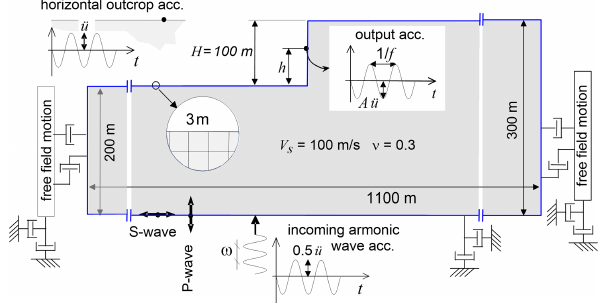
Figure 3. Numerical model used for the seismic response of a ver- tical